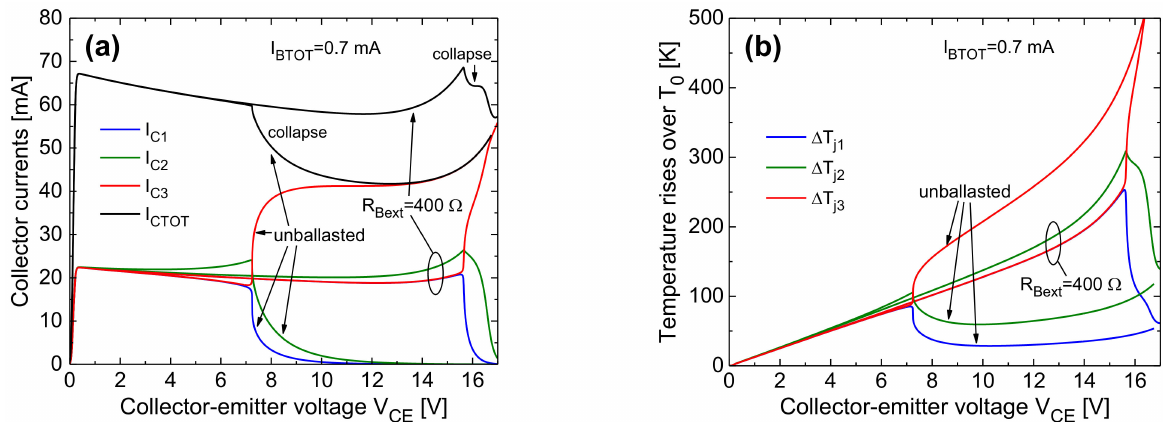
Figure 16. Test device with three unit cells, either unballasted or ballasted with R Bext = 400 Ω per cell: simulated ( a ) collector currents and ( b ) junction temperature rises over T 0 vs. collector-emitter voltage V CE